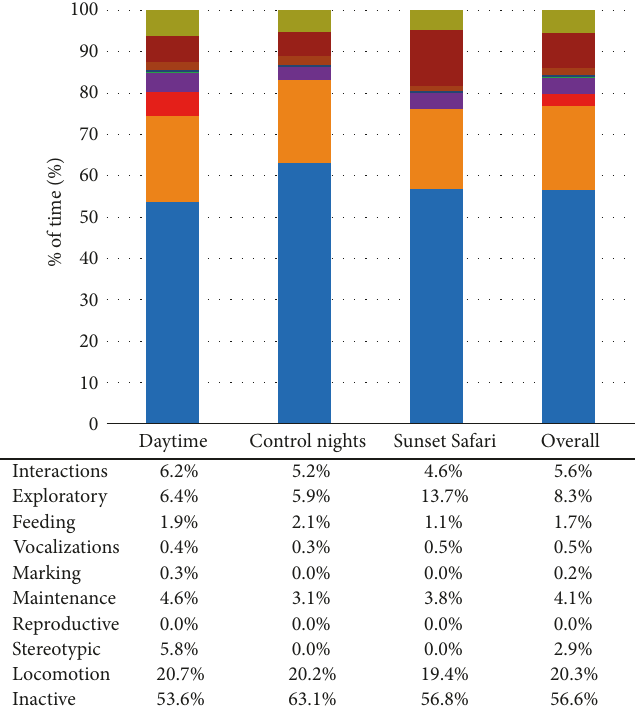
Figure 1: Rubi’s time budget for each observation period and overall at London Zoo. Data values are included to show exact percentages of time for each behavior class.